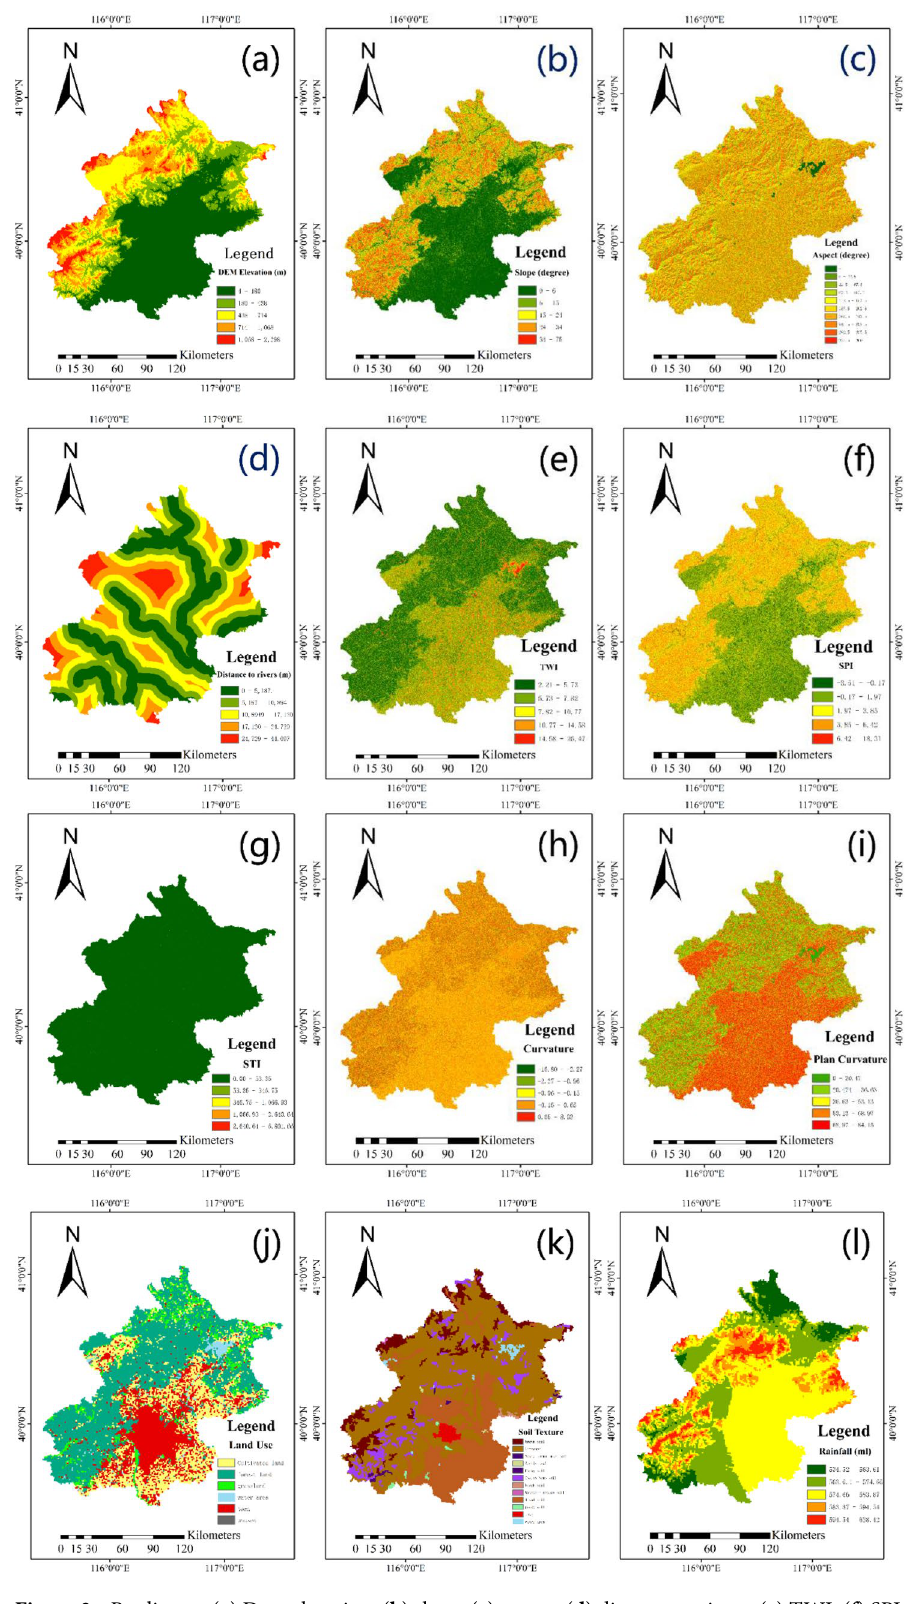
Figure 3. Predictors: ( a ) Dem elevation, ( b ) slope, ( c ) aspect, ( d ) distance to rivers, ( e ) TWI, ( f ) SPI, ( g ) STI, ( h ) curvature, ( i ) plan curvature, ( j ) LULC, ( k ) soil, ( l ) rainfall (we plotted the map using arcgis10.7. http:// www. esri. com/ sofwa re/